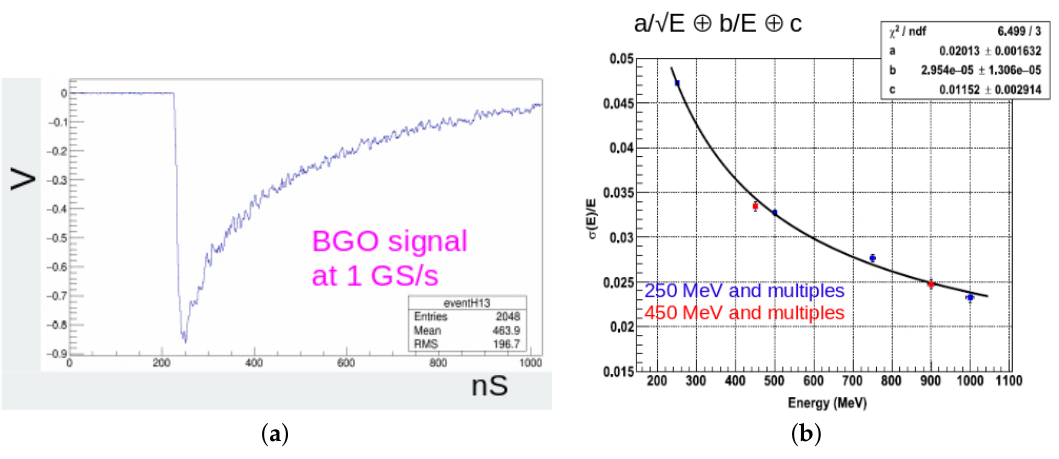
Figure 4. ( a ) BGO signal digitized at 1 GS/s; and ( b ) ECAL 2016 BTF test energy resolution